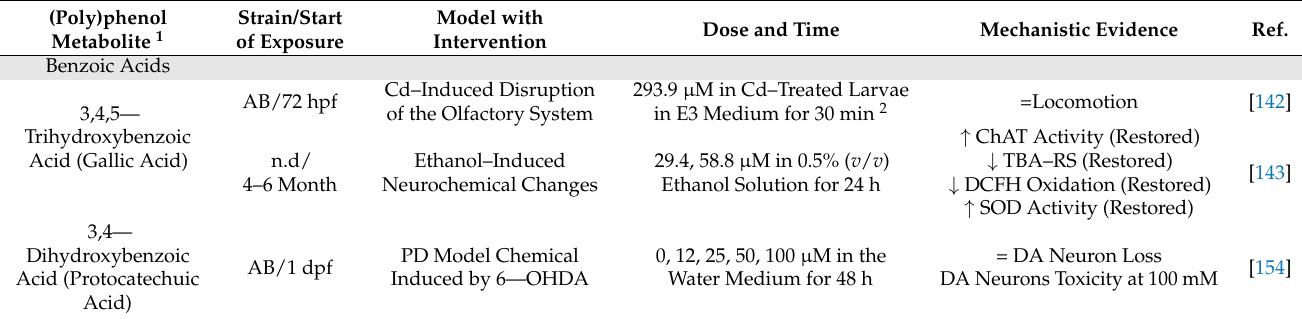
Table 6. Effects low molecular weight (poly)phenol metabolites in zebrafish models of